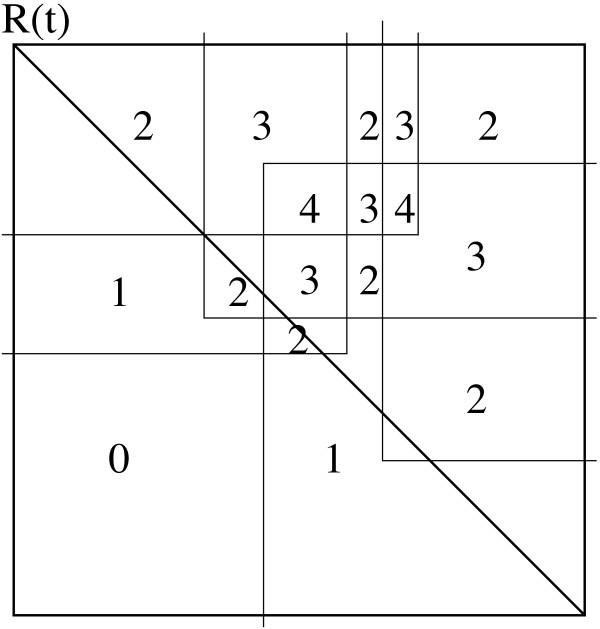
Computing the maximal cliques regarding the hypotenuse t by intersection r (t) with Pr(t),Qr(t) and Rr(t). In the example, we have two rectangles from Pr(t), two from Rr(t) and one from Q(t). The numbers denote the cover-values of the corresponding polygons.